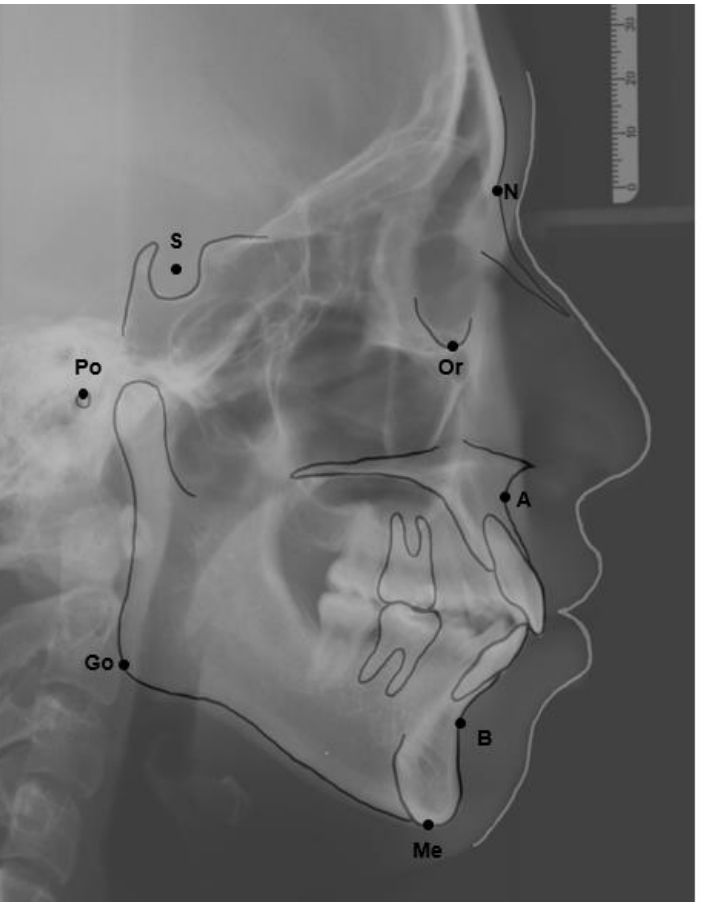
Figure 1. The reference lateral cephalometric radiographic tracing points used in the study. A point: The innermost point on the curvature of the surface of the maxillary bone. B point: The innermost point on the contour of the mandible. Go: gonion: the intersection of the line tangent to the posterior and inferior angle of the mandible. Me: menton, the most inferior point on the mandibular symphysis. N: nasion, the most anterior point of the intersection between the nasal and frontal bones (frontonasal suture). S: sella, the midpoint of the sella turcica. Po: porion, the most superior point of the contour of the external auditory meatus. Or: orbitale, the most inferior point on the margin of the orbit.